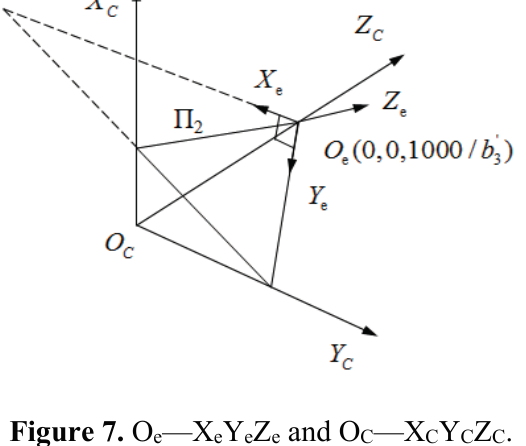
Figure 7. O e —X e Y e Z e and O C —X C Y C Z C